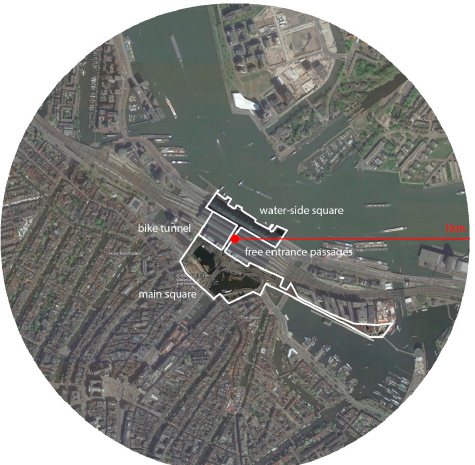
Figure 1. Study area defined as the public area within a 1 km radius around the station, including Stationsplein (main square), Waterplein (the water ‐ side public space), and the free entrance passages under the railway platforms connecting the squares on both sides of the station (ticket ‐ free indoor passage with commercial functions). 2. Place Quality in Station Areas and Its Dimensions This paper conceptualizes station areas as a hybrid between transit hub, central business district, and gateway to city life, highlighting seven dimensions of place quality that frame transit services, business and commercial activity, and the image value of station areas [27]. Building on Bertolini’s node ‐ place model, station areas exhibit both characteristics of a traffic node (emphasizing the transit services) and of urban place (emphasizing the economic development of surrounding urban space). While the original model equated the place value with economic activity, namely, the number of employees, commercial establishments, and office buildings, subsequent research has applied and extended this model, refining the functions of “urban place”, and highlighting users’ experiences of social life [28,29]. Groenendijk et al. [21] extended the node ‐ place model with a third dimension: the experience lens that provides improvements of users’ comfort. Next to the functional factor of making the transfer easier and reducing the waiting time, Hernandez and Monzon [15] identify the users’ psychological perspective for an urban gateway experience—that is, to make the stay more comfortable. Zemp et al. [30] described station areas as having five generic functions which can be sorted into three perspectives: function as a traffic node that provides transit services (connecting catchment area and rail network, supporting intermodal transfer between modes), providing a place for business and social activities (facilitating commercial use, providing public space), and a gateway experience (shaping the place identity). Below, we apply these three perspectives to review the literature and identify the main dimensions/variables that structure the empirical part.